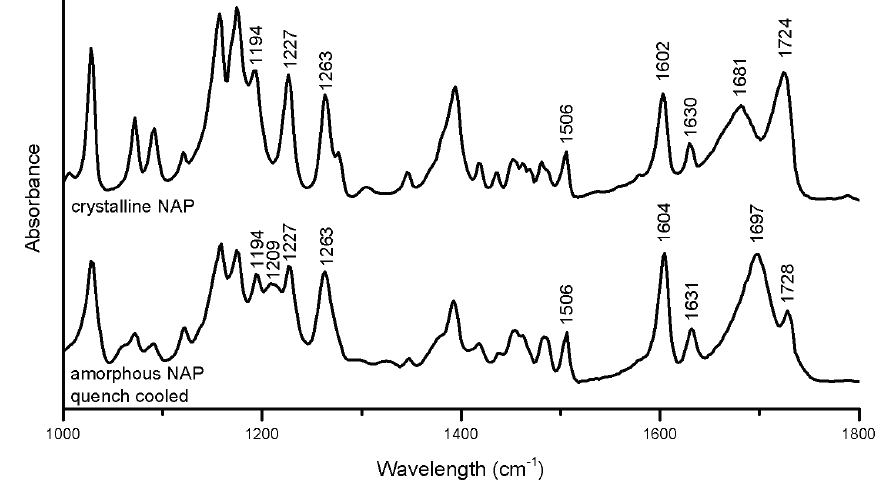
Figure 5. FTIR spectra of crystalline and amorphous NAP prepared by quench